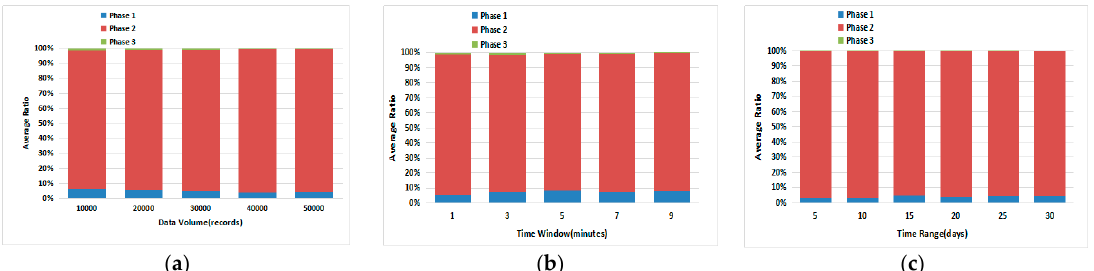
Figure 12. Average Ratio for Different Phases in the Query Process: ( a ) Varying Data Volume; ( b ) Varying Time Window; ( c ) Varying Time Range.